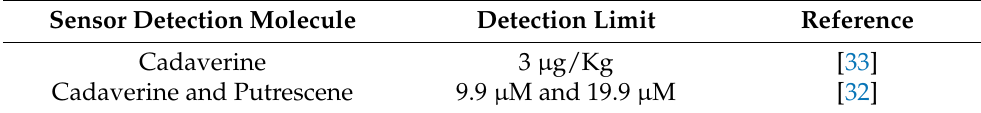
Table 1. Previous reports of cadaverine, and other polyamine-based biosensors and their detection limits.